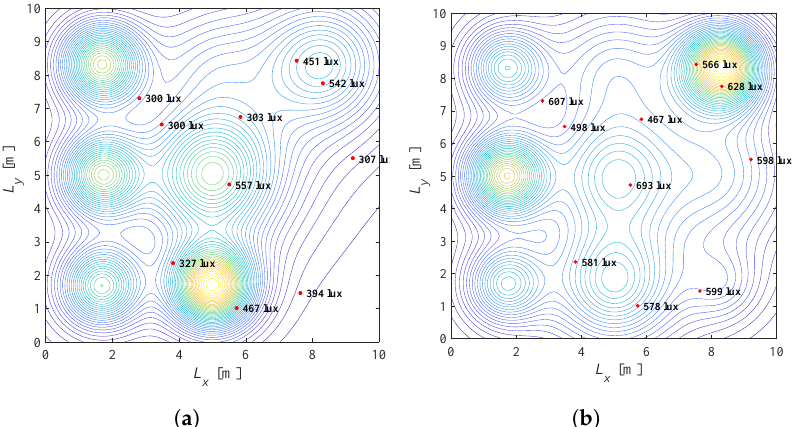
Figure 9. Solution of the Problem 2 defined in (15). ( a ) λ = 0.01, G = 0.31. ( b ) λ = 0.5, G =